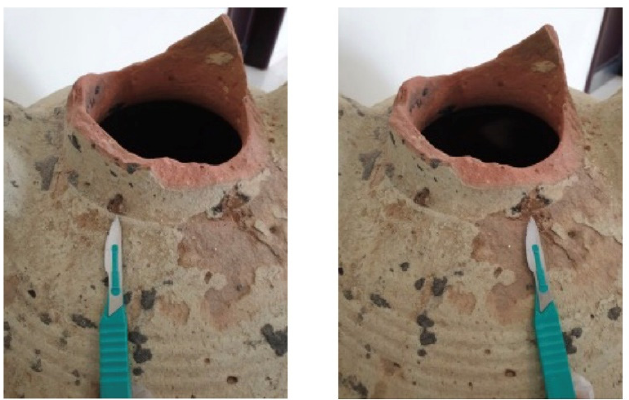
Figure 5. Sampling sites of the Muhut amphora (© Ministry of Heritage and Tourism).